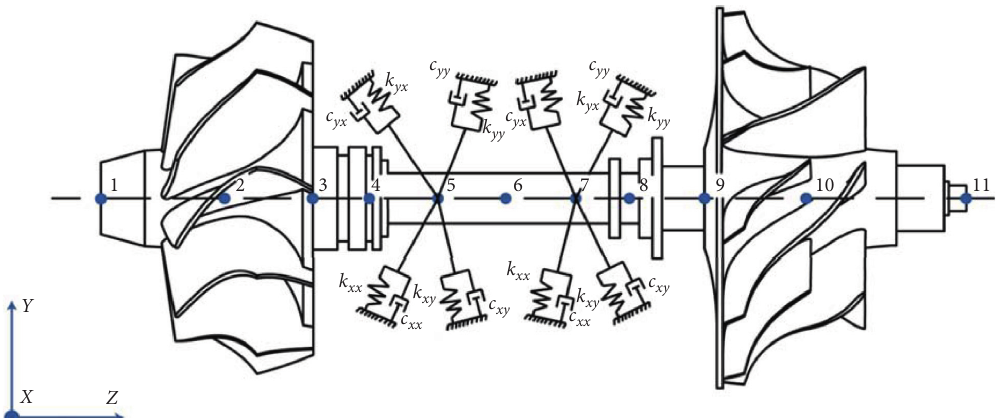
Figure 10: Finite element model of rotor-shaft system.